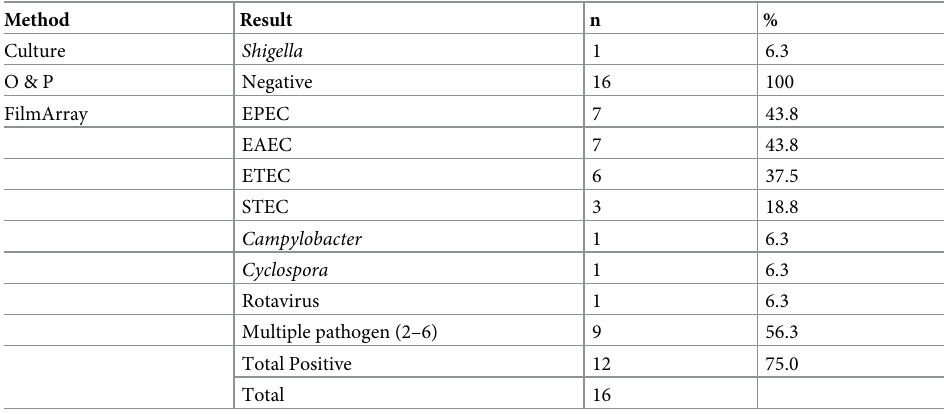
Table 7. Study 2 laboratory results. O & P indicates ova and